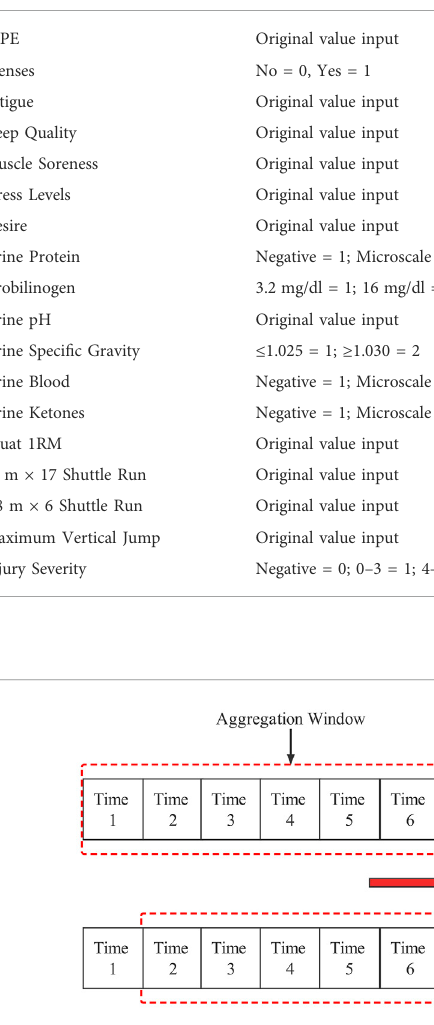
FIGURE 1 Schematic diagram of the aggregation and prediction sliding